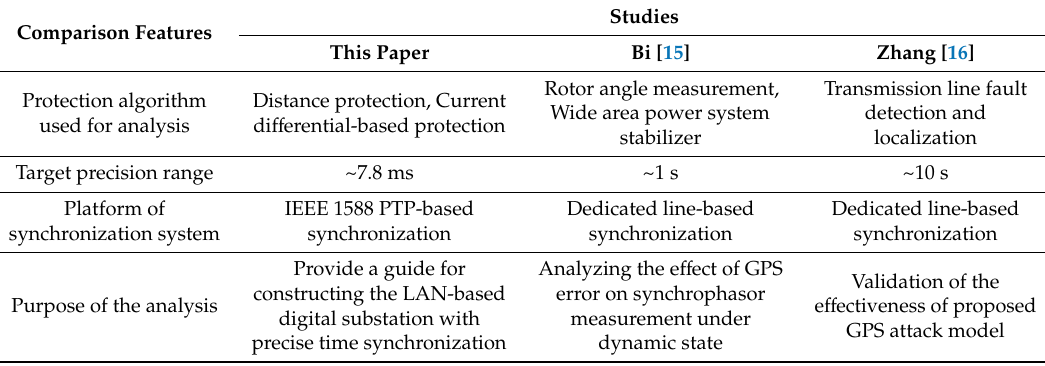
Table 2. Comparison summary: di ff erent approaches of analyzing the e ff ect of time synchronization error in power system.